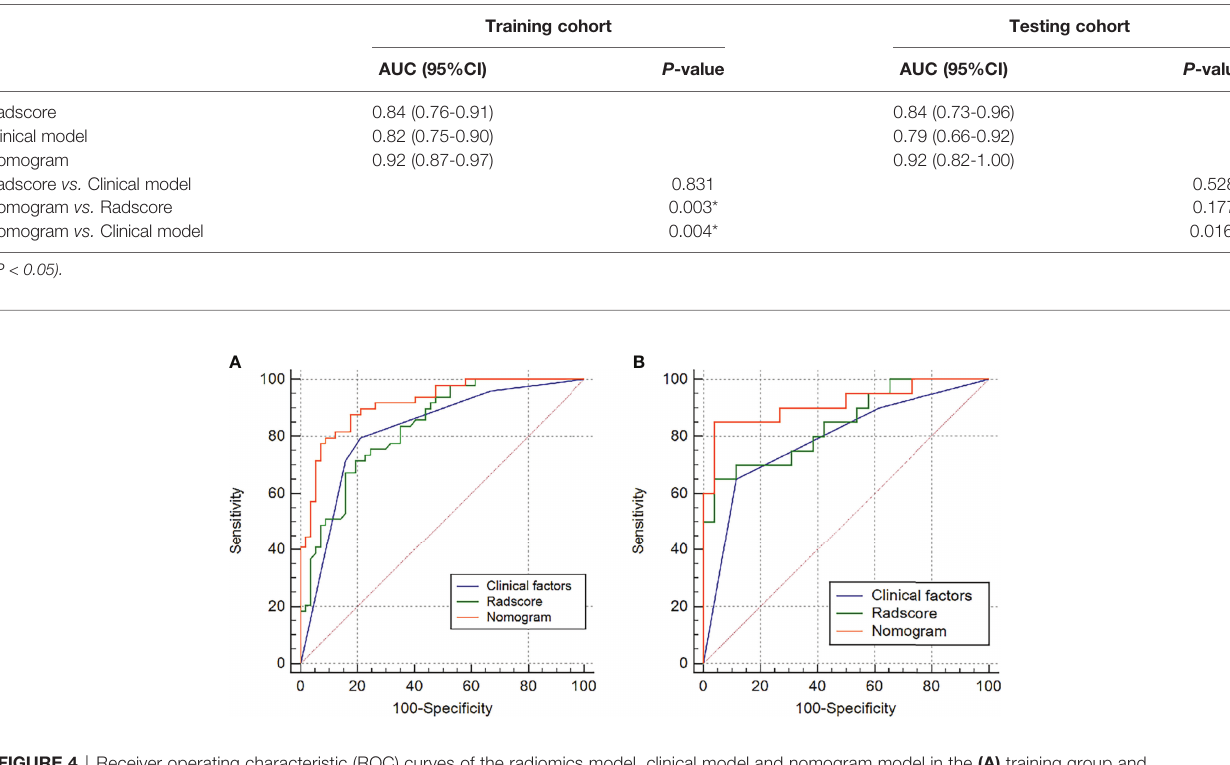
FIGURE 4 | Receiver operating characteristic (ROC) curves of the radiomics model, clinical model and nomogram model in the (A) training group and (B) testing group.